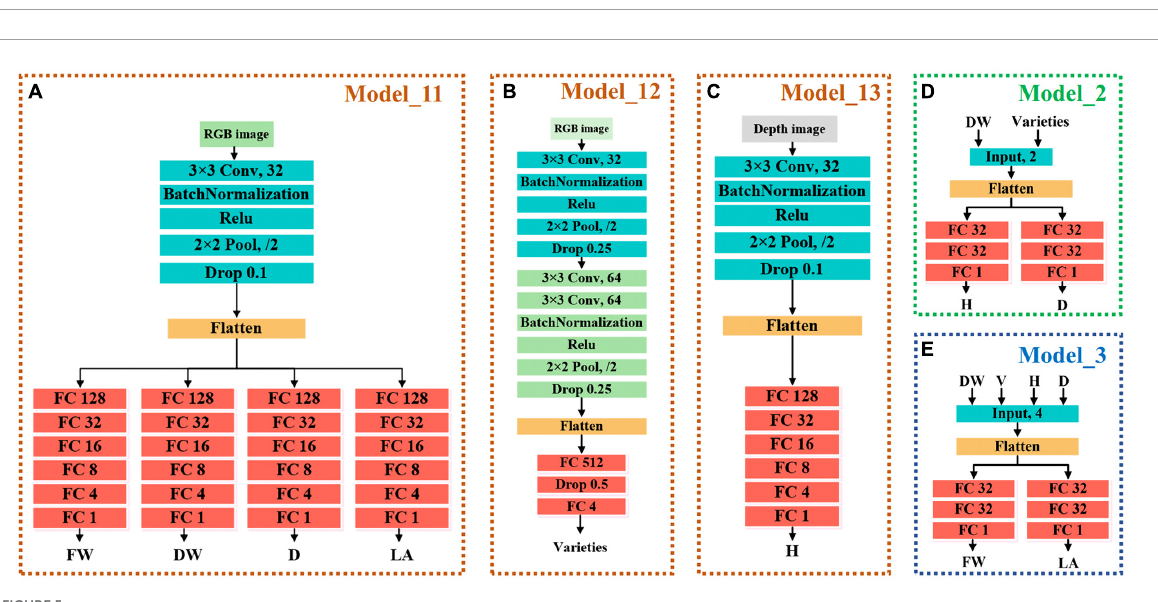
The output results of Model_2 and Model_3 were not the final lettuce estimated values but were only used to automatically correct the output of master models. The modified